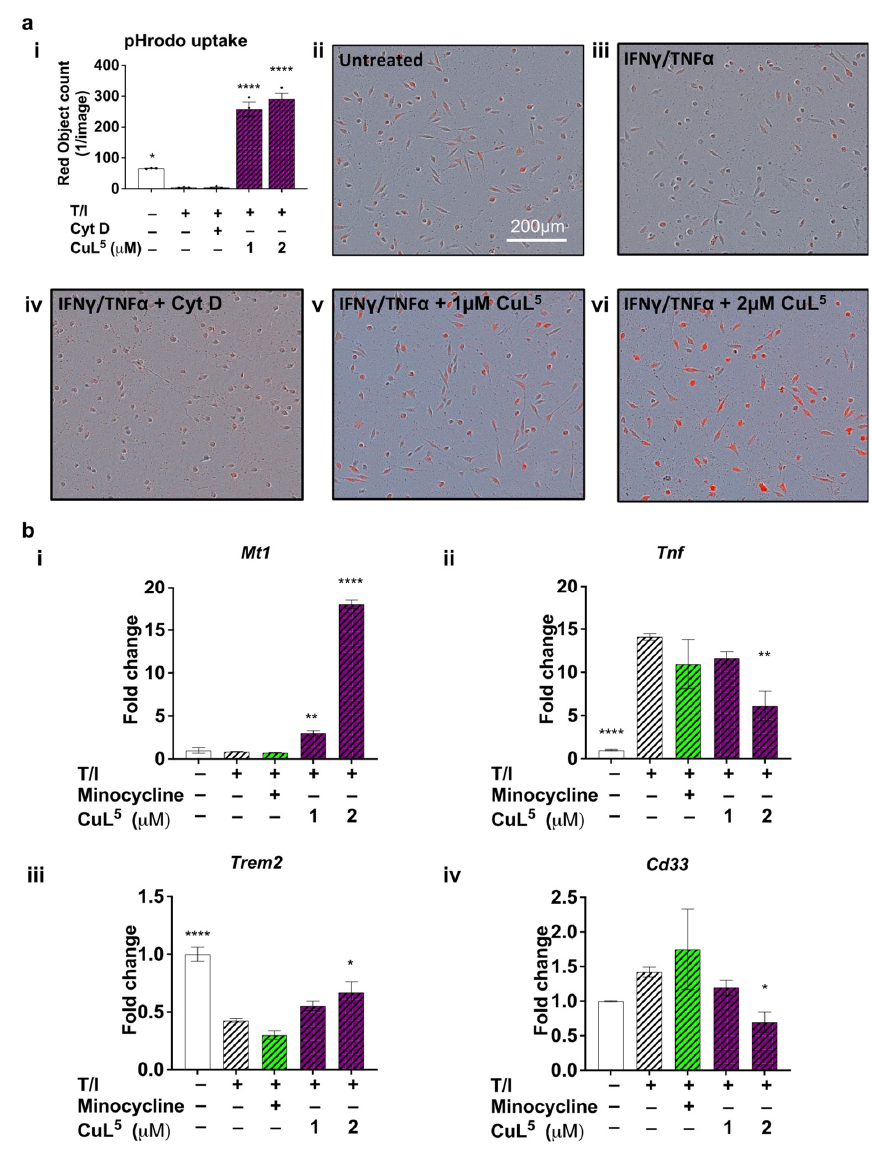
Figure 3. CuL 5 treatment modulated microglial phagocytic activity. Primary murine microglial cultures were stimulated with TNF α (10 ng/mL) and IFN γ (15 ng/mL) and concurrently treated with 10 μM cytochalasin D, 20 μM minocycline, 1 μM CuL 5 , or 2 μM CuL 5 for up to 24 h. ( a ) 1 h post-stimulation and treatment, media were removed and replaced with 100 μg/mL pHrodo red E.coli bioparticles and fluorescence emission was measured using the IncuCyte imaging platform every 2 h. ( aii – avi ) Representative images from one experiment showing phase contrast and red channel signal with respective conditions. An actin inhibitor, cytochalasin D (10 μM) was incubated 1 h prior to the addition of E.coli bioparticles to validate pHrodo-labeled uptake . Scale bar = 200 μm. ( b ) The 24 h post-stimulation and treatment, RNA was extracted from cells for cDNA synthesis. qRT-PCR was used to determine mRNA expression levels of ( bi ) Tnf , ( bii ) Mt1 , ( biii ) Trem2 and ( biv ) Cd33 . Results obtained were normalised to mRNA expression level of Hprt . ( ai ) Data are expressed as the average red object count (1/image) of pHrodo-labeled microglial cells in each condition. Three images per well from three technical replicates were analysed. ( b ) Representative data set is expressed as fold induction relative to media-only control. Data are presented as the mean ± S.E.M. Determined by one-way ANOVA, compared to ( bi ) media-only or ( ai , bii – biv ) TNF α - and IFN γ -stimulated controls, */**/**** = p ≤